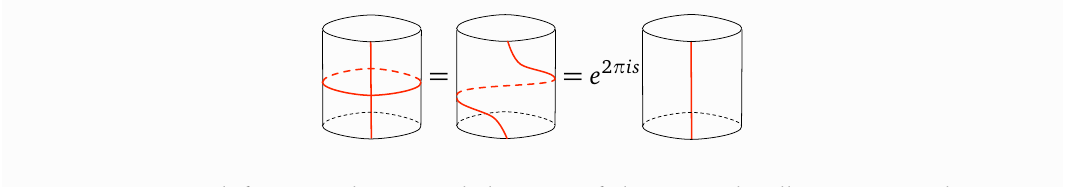
Figure 1: (cid:90) defect, (cid:90) charge and the spin of the twisted Hilbert space. The (cid:90) 2 2 charge of a state in the (cid:90) is given by the leftmost figure, which can be deformed to 2 the middle figure. Therefore the charge is related to the spin of the state. When we put a (cid:90) -invariant boundary condition on the top and bottom slices, we can always 2 unwind the defect, and the spin is always integer